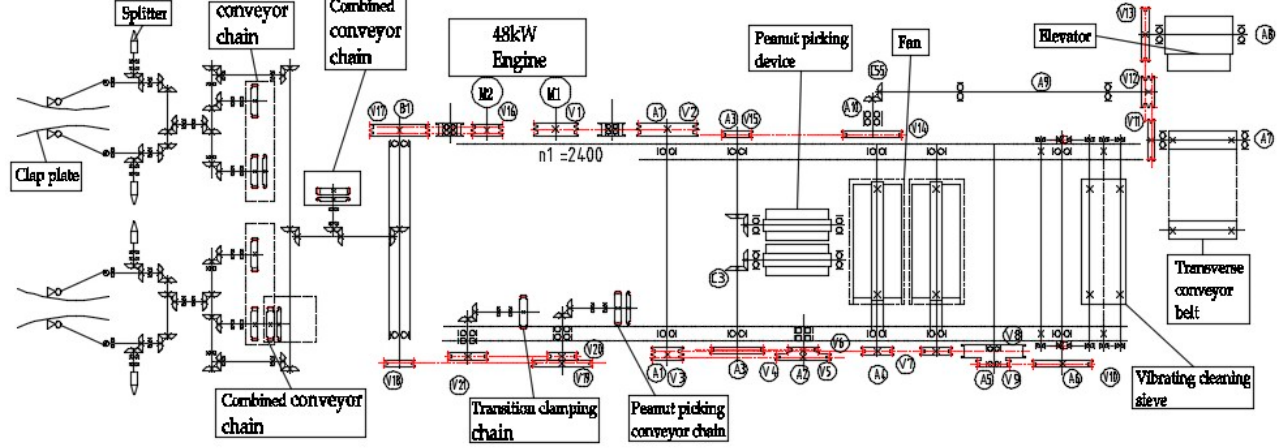
Figure 3. The transmission system configuration of the 4HLB-4 half-feed four-row peanut combine harvester. Note: A1-A8, B1 are the drive shafts; V1-V21 are the drive pulleys.